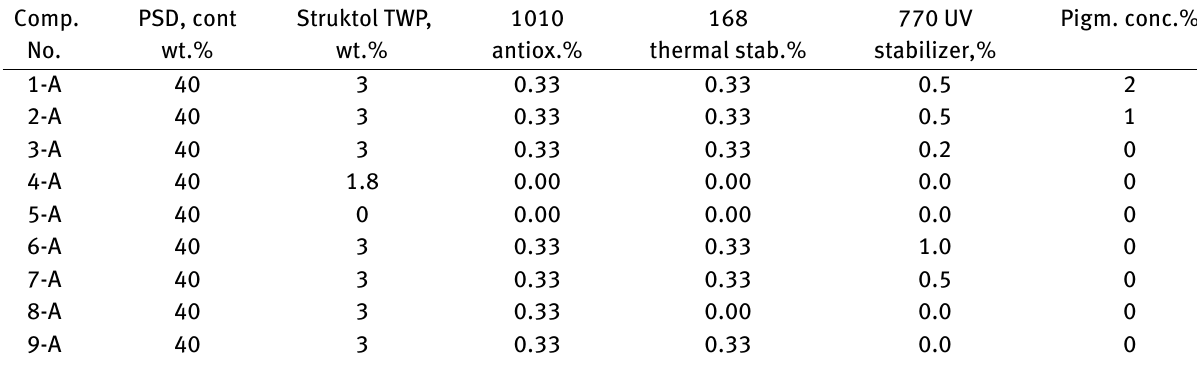
Table 1: WPCs based on polypropylene + 40 wt.% birch plywood sanding dust (PSD) composition. Comp. Struktol TWP,